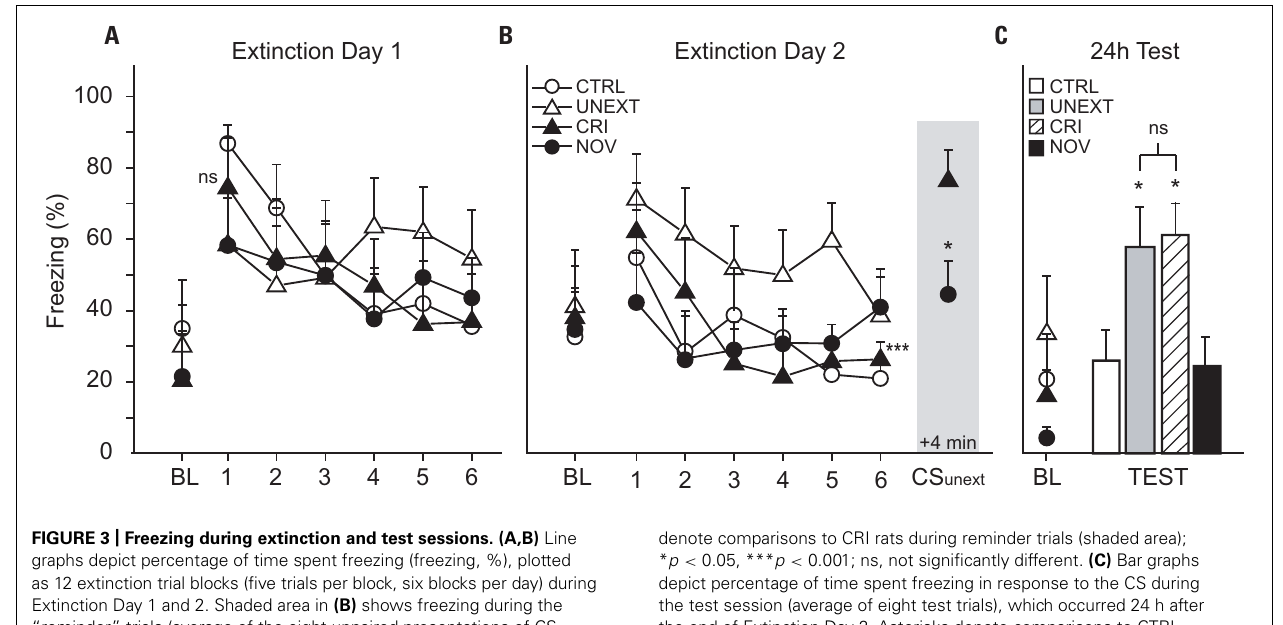
FIGURE 3 | Freezing during extinction and test sessions. (A,B) Line graphs depict percentage of time spent freezing (freezing, %), plotted as 12 extinction trial blocks (five trials per block, six blocks per day) during Extinction Day 1 and 2. Shaded area in (B) shows freezing during the “reminder” trials (average of the eight unpaired presentations of CS Unext or CS Nov ), which began 4 min after the last CS Ext trial on Day 2. Asterisks